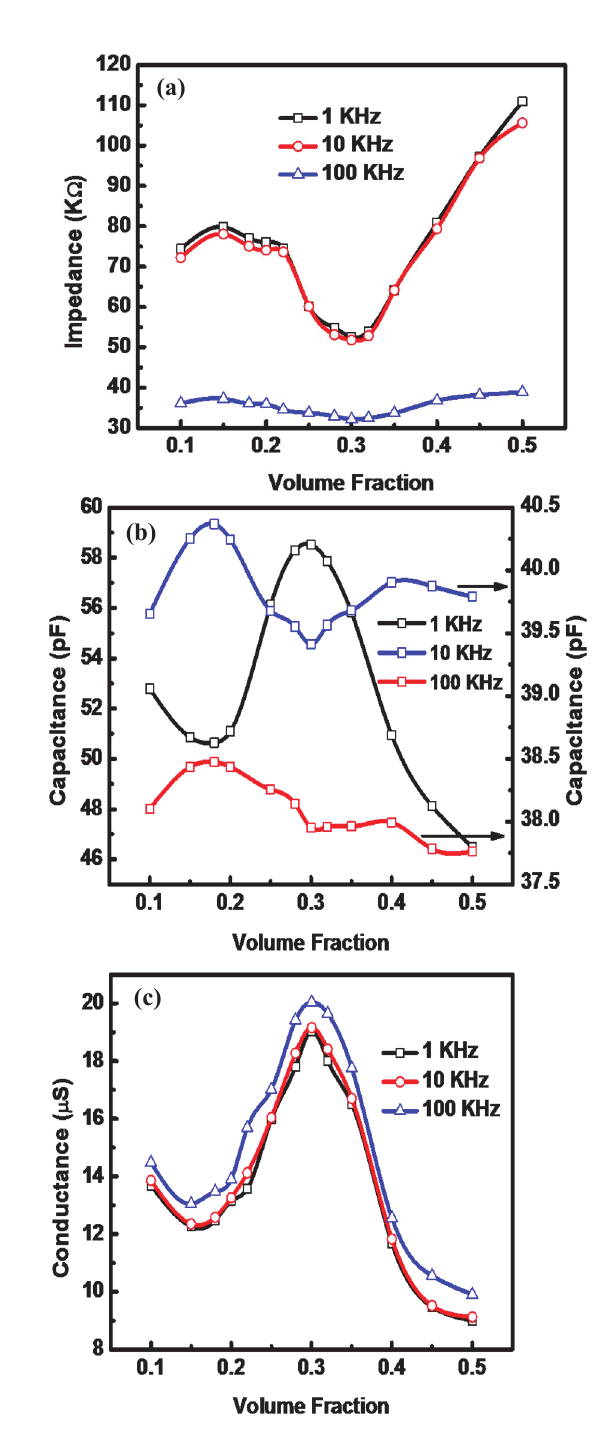
Fig. 3: Plots of the variations of electrical parameters with volume fraction of glucose in DI water: (a) variation of impedance 1 kHz, 10 kHz and 100 kHz; (b) variation of capacitance at frequencies 1 kHz, 10 kHz and 100 kHz and; (c) variation of conductance at 1 kHz, 10 kHz and 100 kHz.